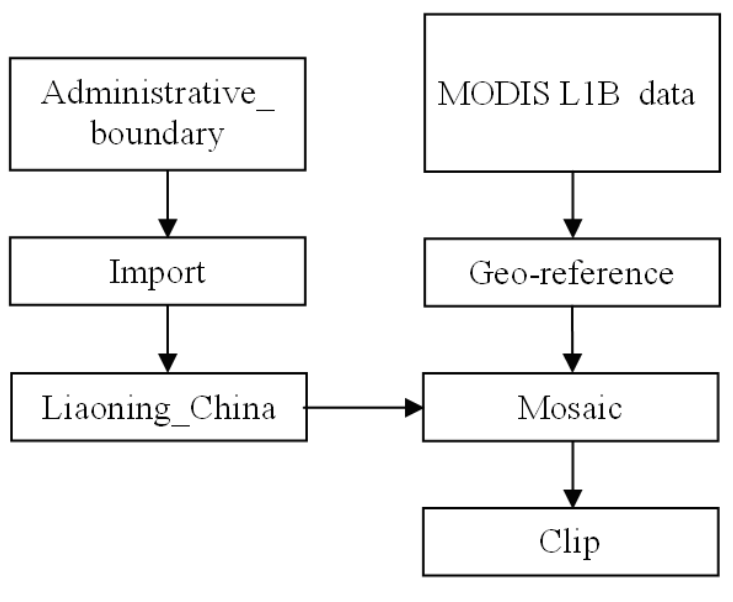
Figure 3. The procedure of MODIS data